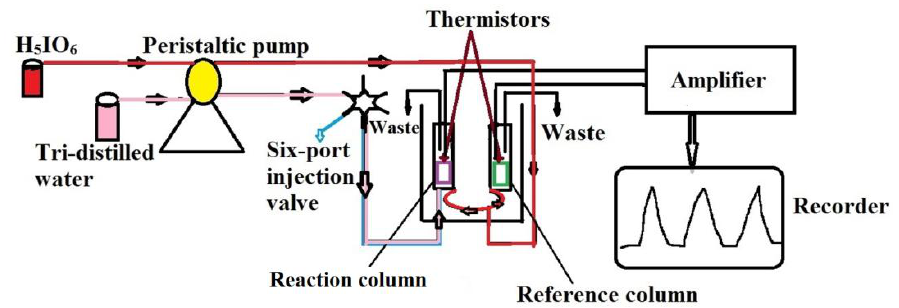
Figure 1. Schematic of the FIA